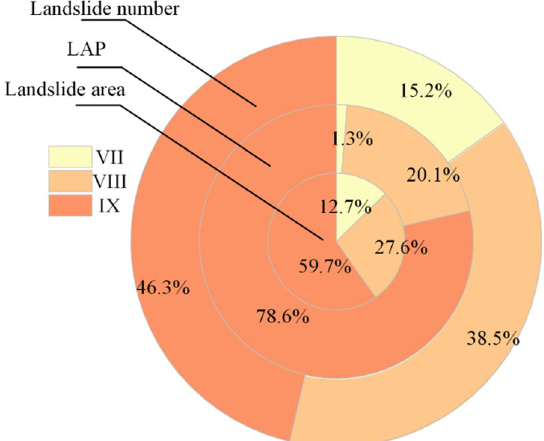
Fig. 6 Analysis diagram for landslide evaluation index and seismic intensity